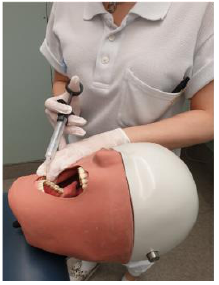
Figure 2. Dental student during model training.